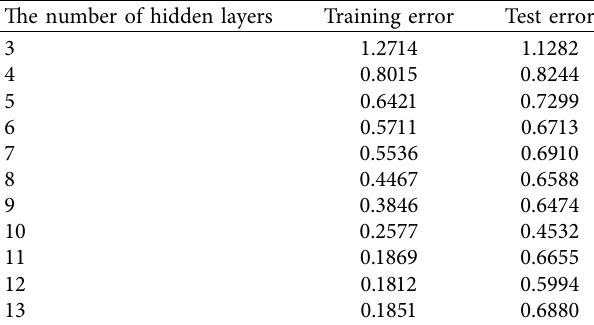
Table 1: Relationship between the number of neurons in the hidden layer and the error.